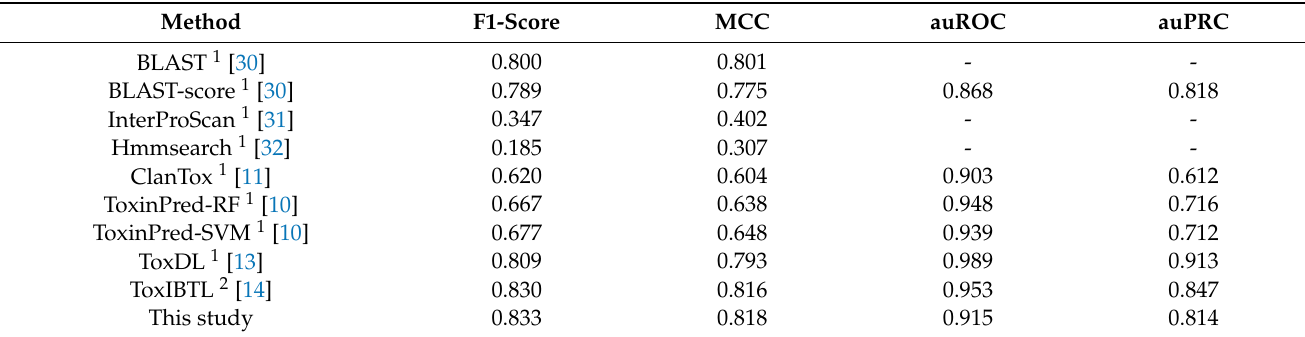
Table 3. Test results on the toxic animal protein